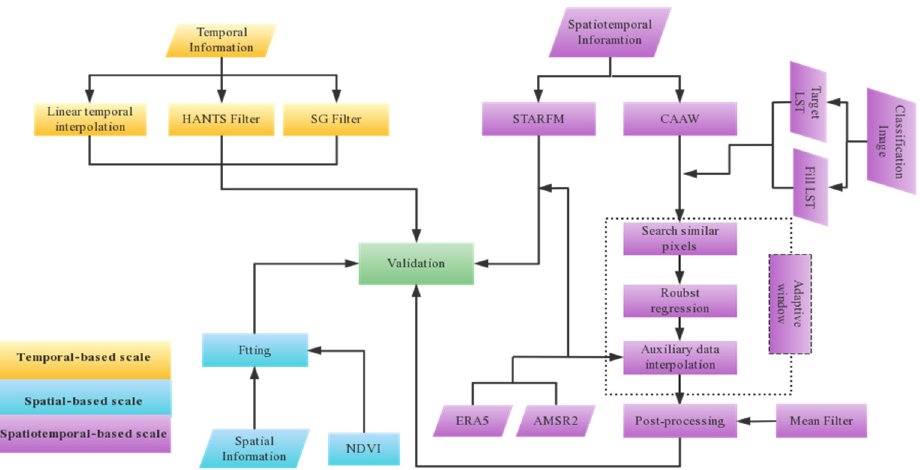
Figure 2. Flowchart of validation and comparison of different reconstruction methods. CAAW indicates the method based on classification and the adaptive window.